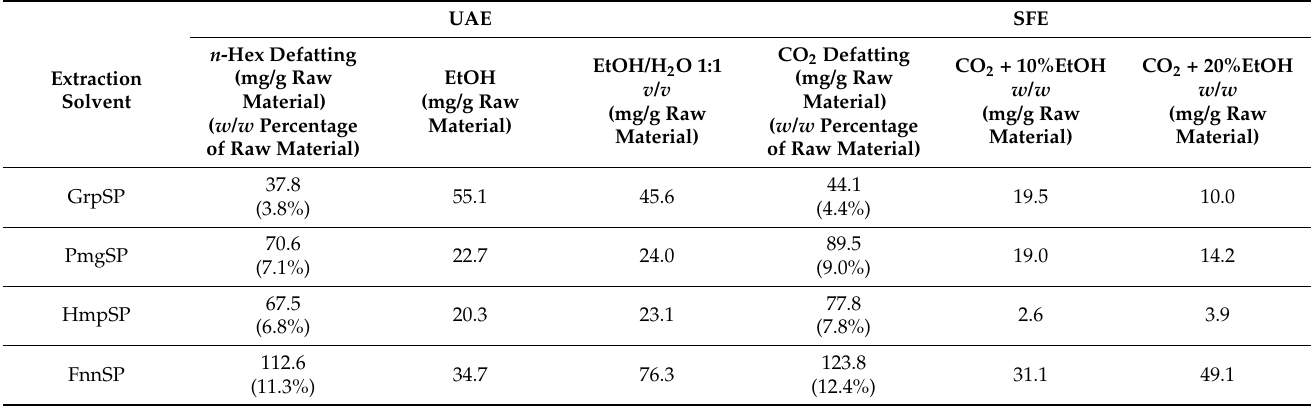
Table 1. Yields of seed paste (VSP) extracts (mg/g of raw material) from grape (GrpSP), pomegranate (PmgSP), cannabis (HmpSP) and fennel (FnnSP) after UAE with n -Hex, EtOH and EtOH/H 2 O 1:1 v / v and SFE with CO 2 , CO 2 with 10%EtOH w / w and CO 2 with 20%EtOH w / w